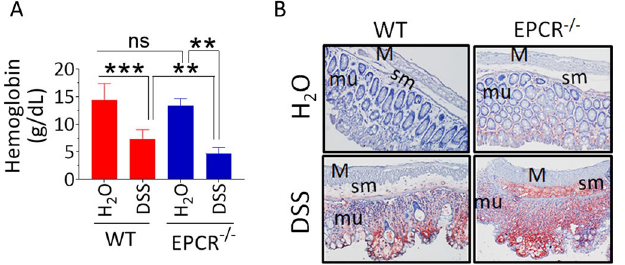
Figure 5. EPCR-deficient mice exhibit increased DSS-induced bleeding and fibrin/fibrinogen deposition in the colon. Blood and colon tissue samples were collected from the control and DSS-treated mice. ( A ) Blood samples were used to measure hemoglobin content. ( B ) The colon tissue sections were stained with fibrin/ fibrinogen antibody overnight, followed by biotinylated secondary antibody and streptavidin-HRP. The sections were developed using the AEC substrate. The sections were counterstained with hematoxylin and imaged at 10X magnification. Red staining indicates positivity for fibrin/fibrinogen. m, muscularis externa; sm, submucosa; mu, mucosa. Data are the mean ± SEM of 2 independent experiments of 8 mice/group. * P < 0 .05; ** P < 0 .01; *** P < 0.001.